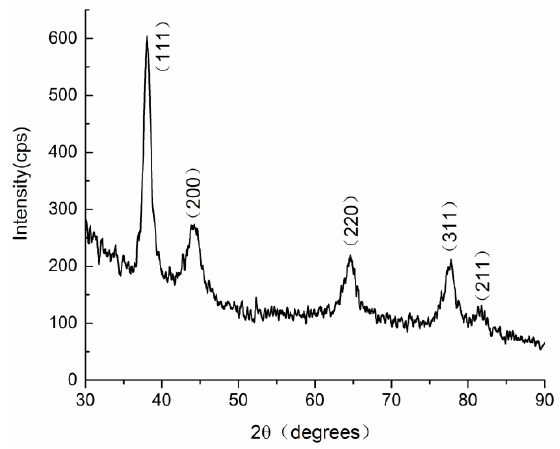
Figure 5. XRD patterns of the proanthocyanidin-functionalized gold nanoparticles.